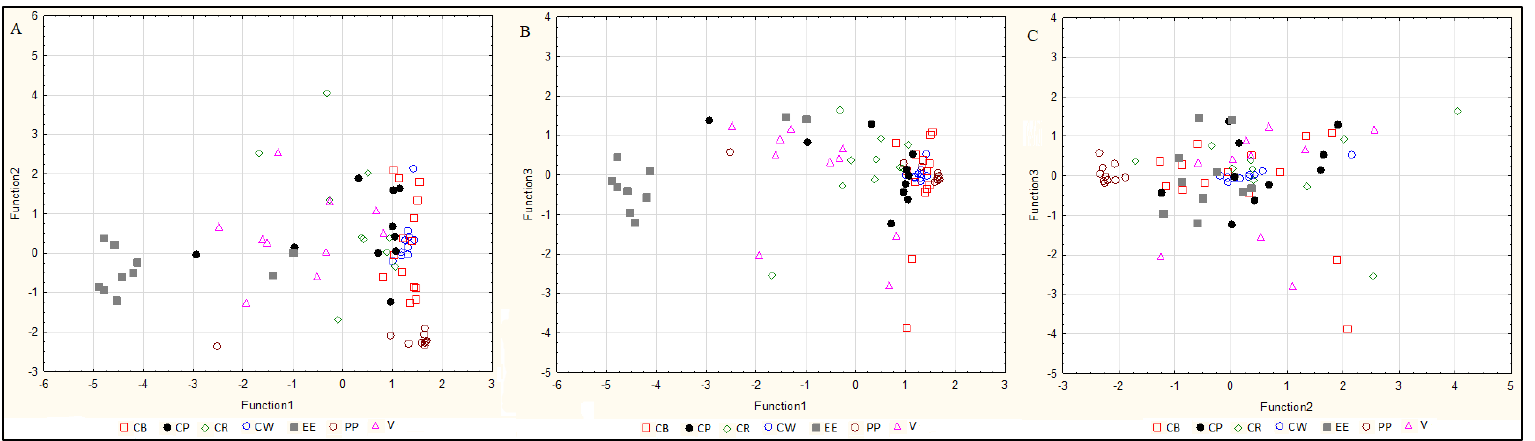
Figure 4. Cluster analysis of raw, smoked and pickled freshwater fish in terms of their Zn content ( A ), Cu content ( B ) and Se content ( C ). P CB — pickled common